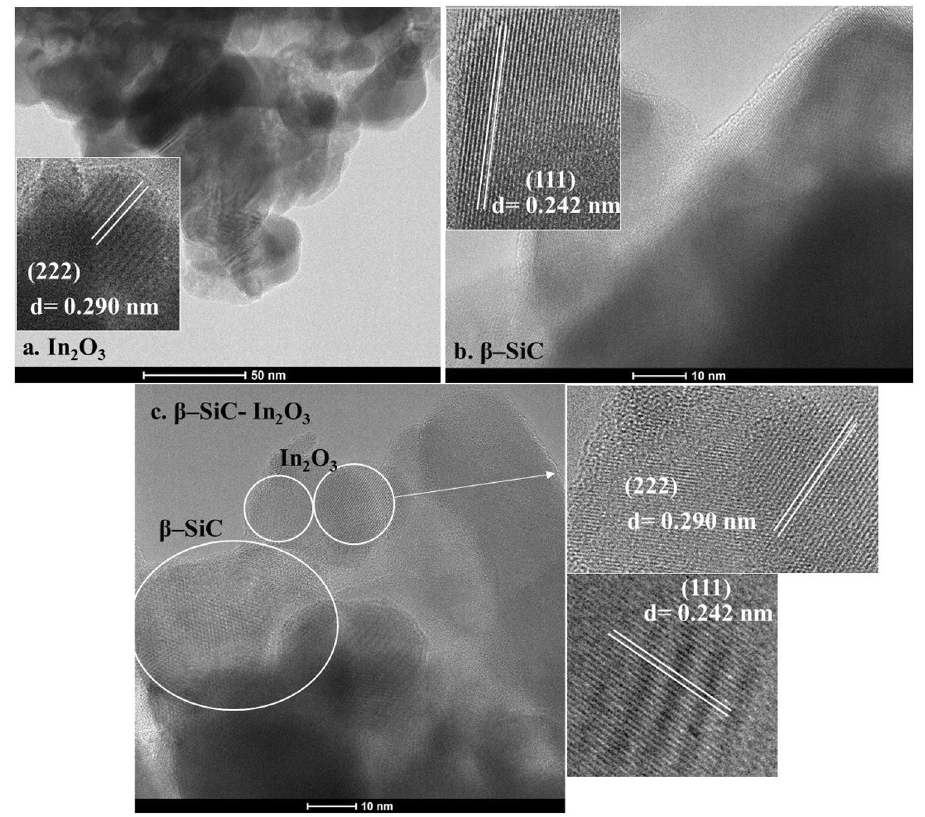
Figure 6. HRTEM images of the ( a ) β-SiC fiber, ( b) In 2 O 3 and ( c ) β-SiC-In 2 O 3 nanocomposite.